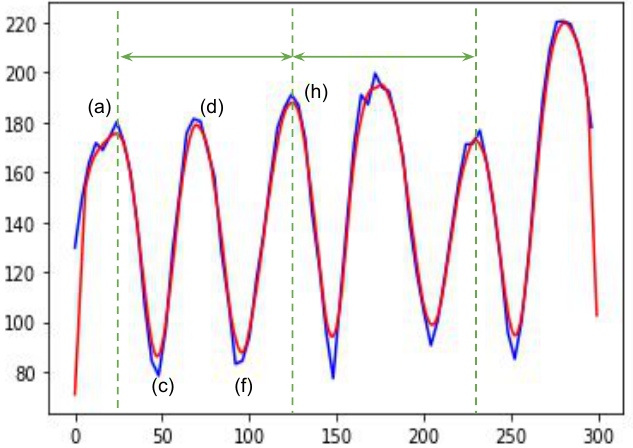
Figure 6. Gait cycle extraction in a sample of d t ( a ) . One gait cycle (green solid line arrows) is from the changes in the distance of two ankles. To remove a subtle change in these ankle distances, data smoothing is applied. The line in blue is raw data. The line in red is after smoothing. The x -axis is for the image frame numbers. The y -axis is for the 3D distances between the two